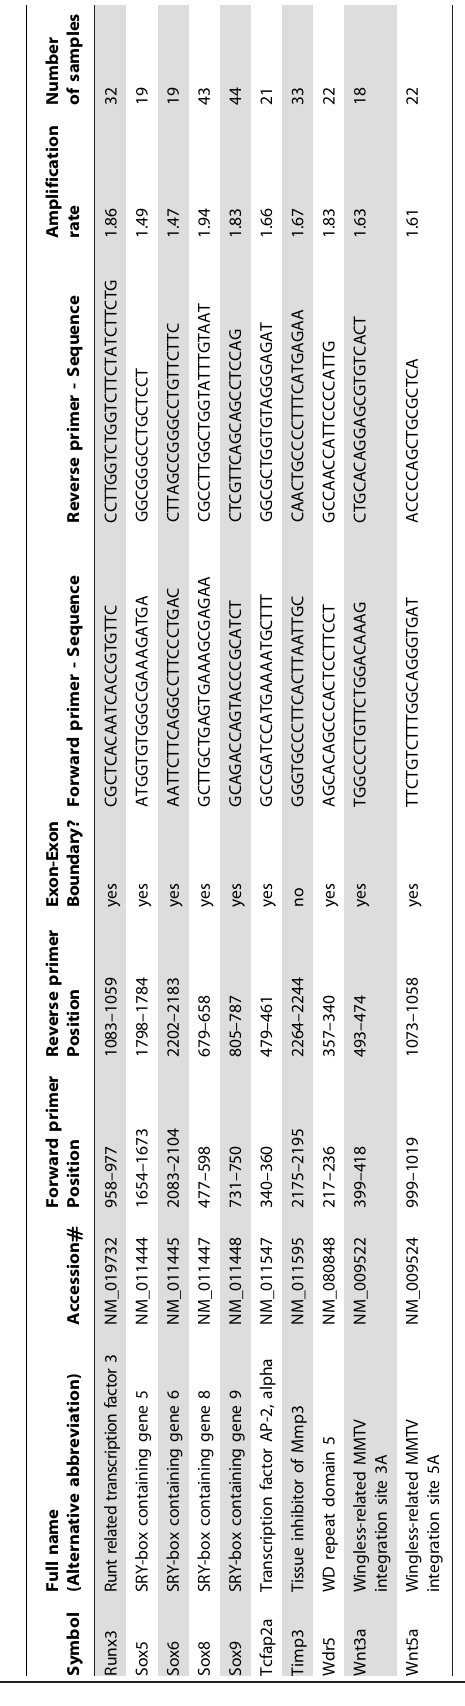
(p , 0.05) for the D C T values of Bmp4, Fgf8, Fgf10, Mmp9, Mmp13, Nos3, Timp3, Wnt3a and Wnt5a (bold in Figure 1A). Except for Wnt3a, all these genes show decreased expression levels in transgenic chondrocytes compared to their littermate controls (Figure 2A). After normalizing to Gapdh, our endogenous reference gene, the fold- change was calculated using the comparative C T method including the correction for amplification rate (Figure 2B). An increased level was found for Wnt3a with overall 5.6-fold (after amplification rate correction) elevated expression in transgenic samples compared to controls. The expression levels of Mmp13 and Fgf10 were more than 2-times lower in Hoxc8-transgenic animals compared to controls. Decreased expression levels of around 1.8-fold were found for Mmp9, Nos3 and Fgf8, and 1.5-fold lower expression for Bmp4 and Wnt5a (Figure 2B). A significant decrease of expression by 1.4-fold was observed for Timp3 in chondrocytes from Hoxc8-transgenic animals compared to controls. Thus, expression levels of Bmp4, Fgf8, Fgf10, S